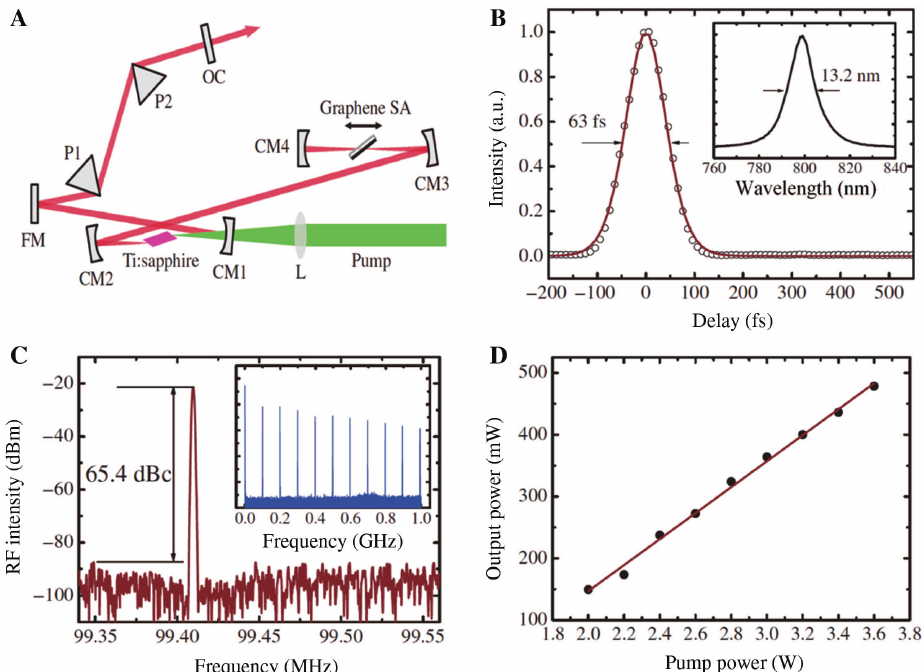
Figure 12: Femtosecond mode-locked lasers with graphene SA. (A) Schematic of the visible mode-locked Ti:sapphire laser. (B) Autocorrelation trace of the Ti:sapphire laser; inset: the corresponding optical spectrum. (C) RF spectrum at fundamental frequency; inset: at 1 GHz span. (D) Output power of the mode-locked laser versus pump power. (A–D) Adapted from Ref. [148], Copyright 2012, The Japan Society of Applied